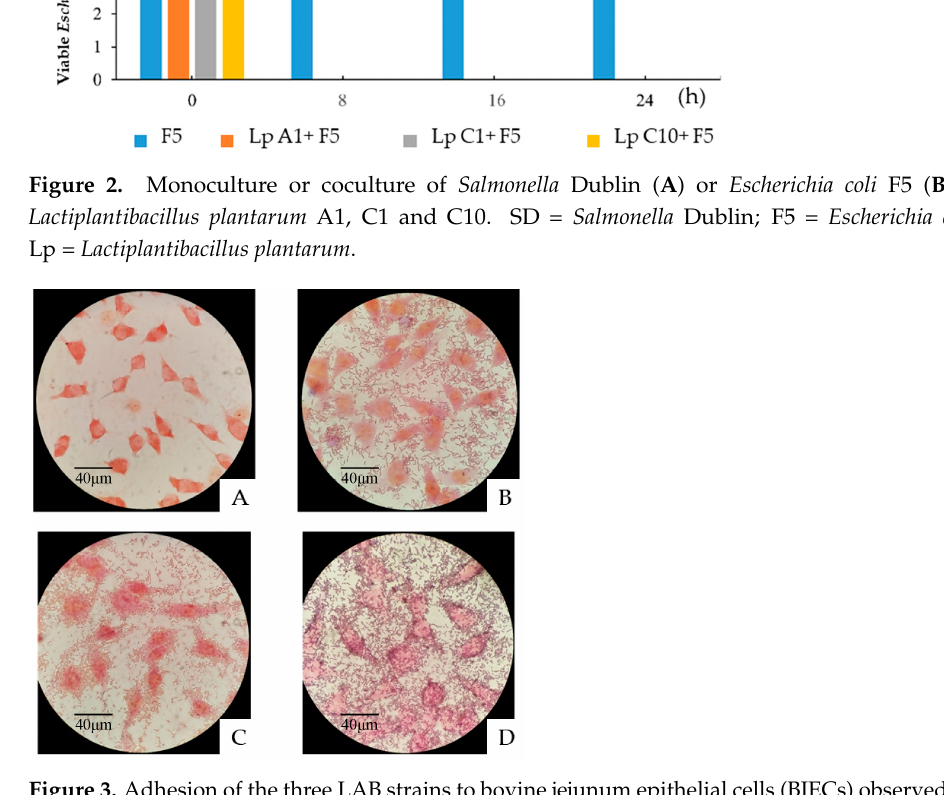
Figure 3. Adhesion of the three LAB strains to bovine jejunum epithelial cells (BJECs) observed under a light microscope. ( A ) Control BJECs. ( B ) Adhesion of Lactiplantibacillus plantarum A1 to the BJECs. ( C ) Adhesion of Lactiplantibacillus plantarum C1 to the BJECs. ( D ) Adhesion of Lactiplantibacillus plantarum C10 to the BJECs.